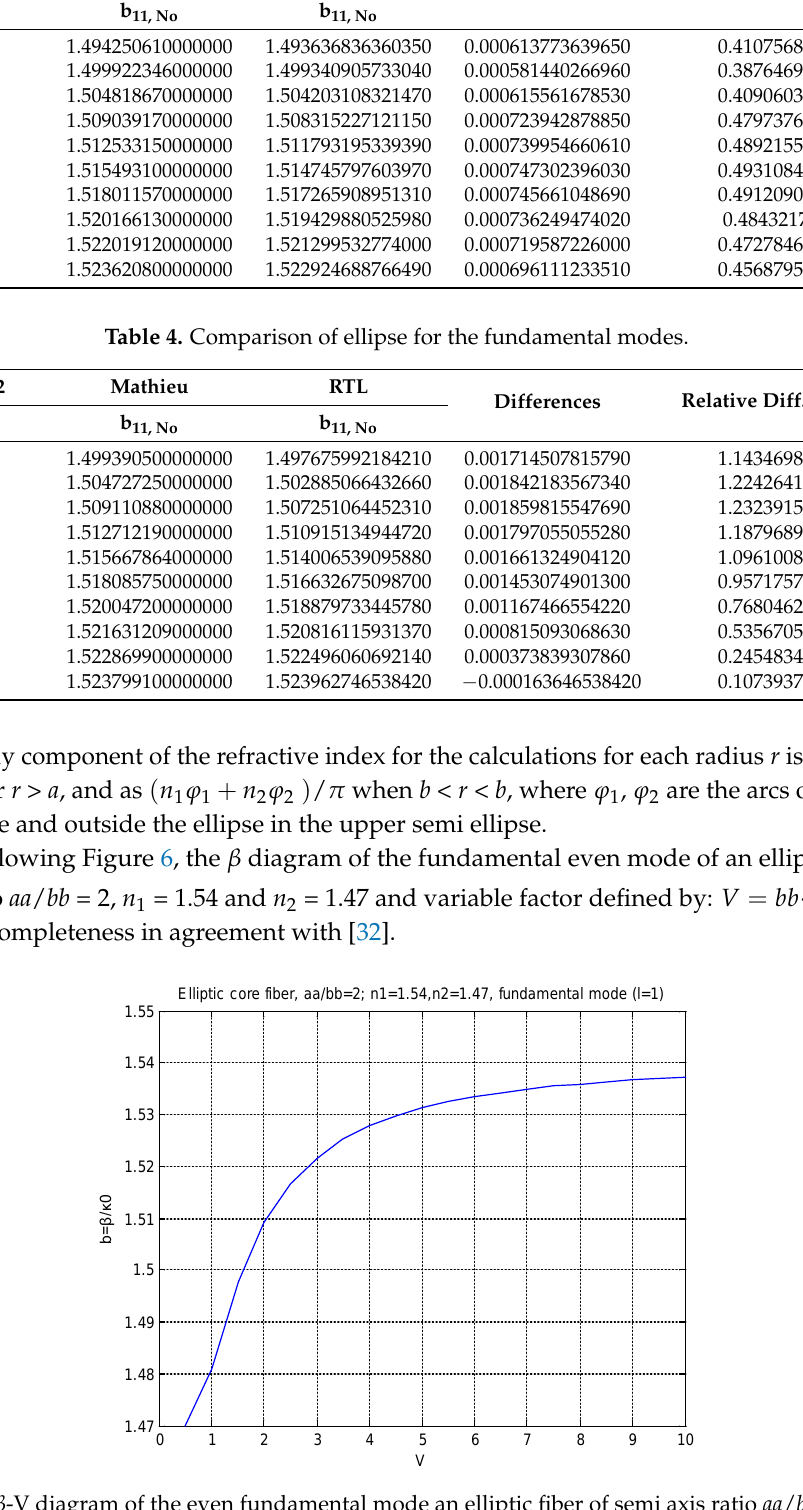
Figure 6. β -V diagram of the even fundamental mode an elliptic fiber of semi axis ratio aa / bb = 2 and core refractive index 1.54 and cladding index 1.47.